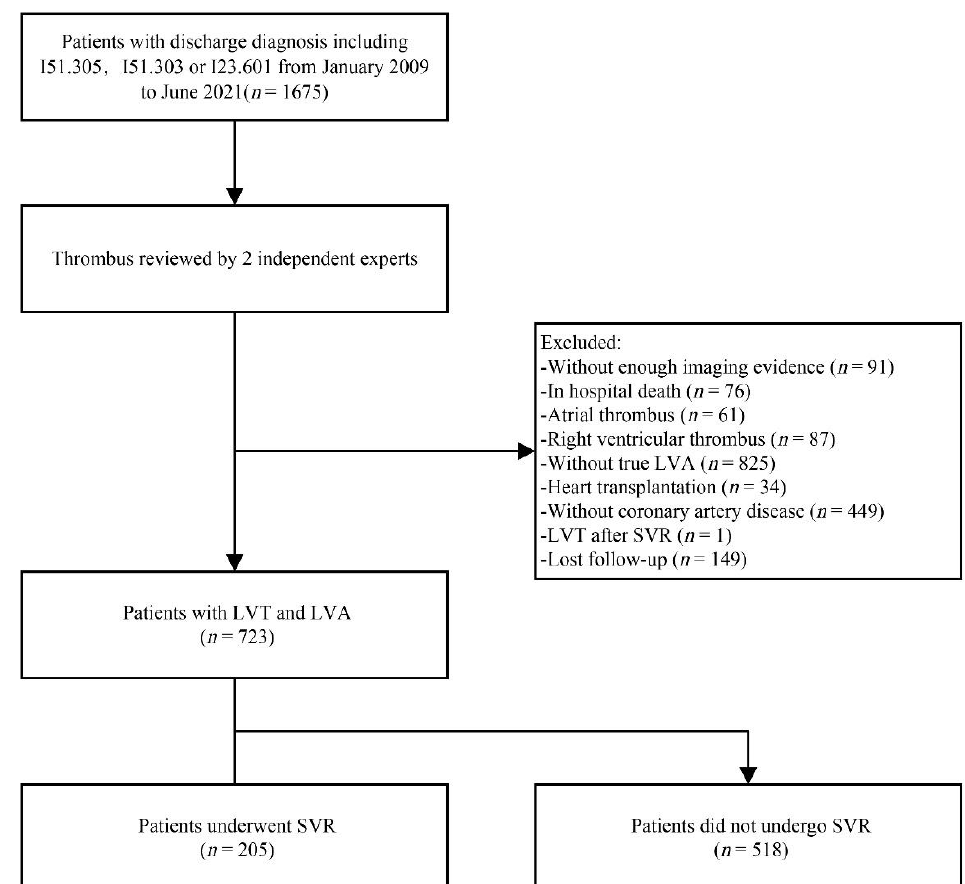
Figure 1. Study flow chart. LVA = left ventricular aneurysm. LVT = left ventricular thrombus. SVR = surgical ventricular reconstruction.